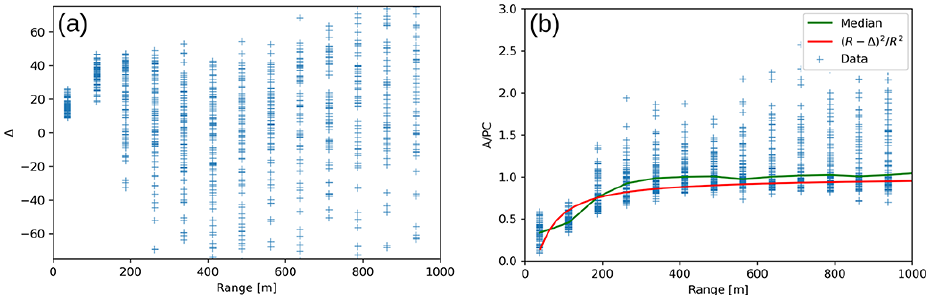
Figure A1. Spatial delay (a) and ratio A/ PC (b) as a function of range.